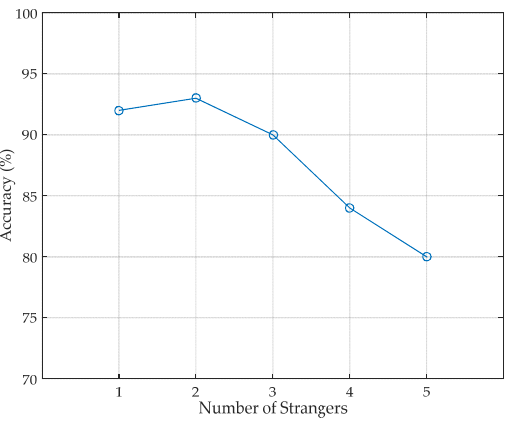
Figure 7. Performance of stranger recognition.